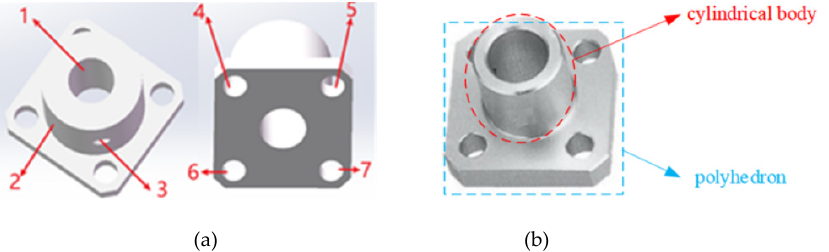
Figure 6. Common mechanical part ( a ) seven cylindrical faces ( b ) one cylindrical body and one polyhedron.